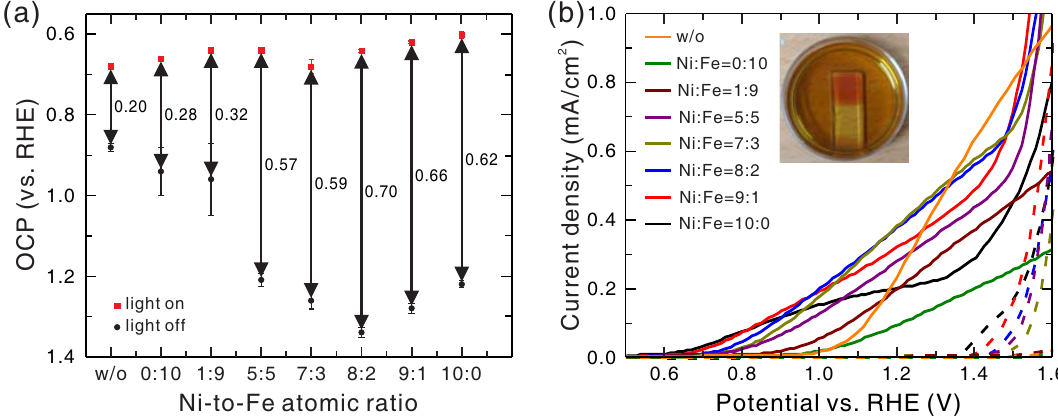
Figure 1. ( a ) open-circuit potentials (OCP) and ( b ) Current density-to-potential (J–V) curves of Ni x Fe 1 − x O y /hematite photoanodes for various Ni-to-Fe ratios of the precursor measured at the light-on (solid line) and light-off (dash line) conditions. The immersion time for depositing Ni x Fe 1 − x O y was 2 min. The case without depositing the electrocatalyst layer is also shown for comparison. The error bars indicate the standard error of mean over three samples. The inset shows a photograph of a sample under chemical bath